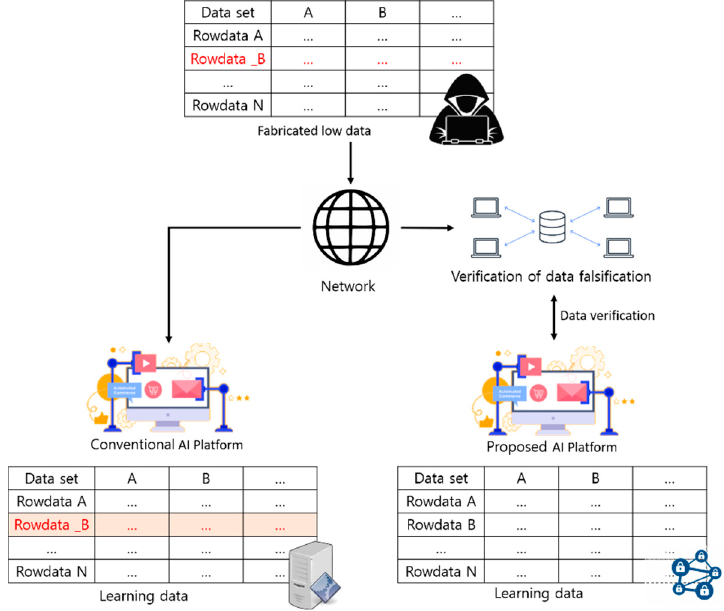
Figure 6. Comparing common AI learning models with the proposed AI learning model.